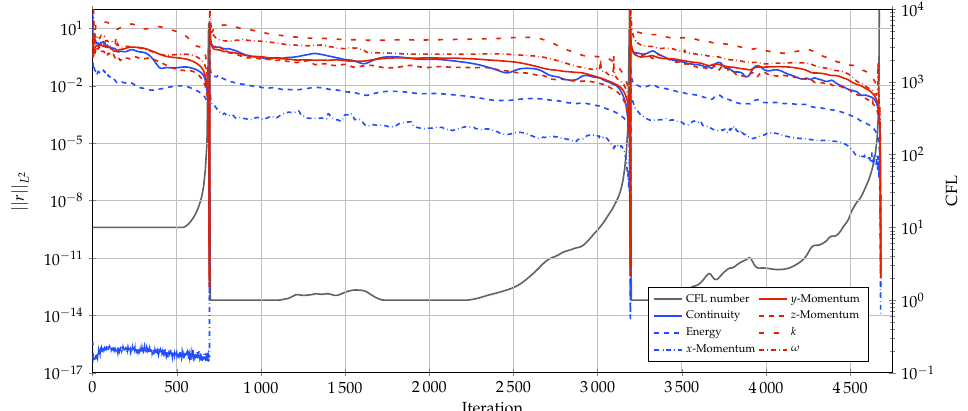
Figure 4. ORC nozzle. Convergence history of the simulation with PR